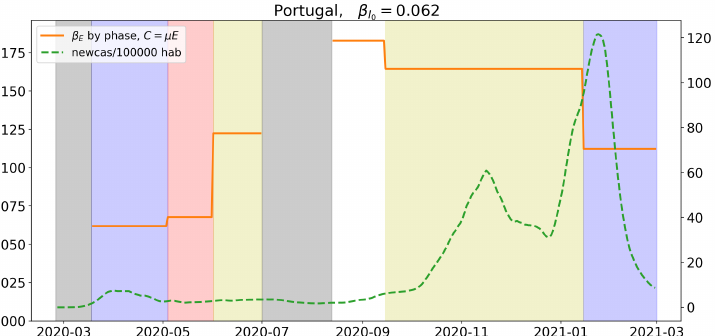
Figure 9. Value of β E for the different levels of lockdown. Blue background will correspond to Stage 1, red to Stage 2, yellow to Stage 3 and white to Stage 4. A green dotted line corresponds to the value of new cases per 100,000